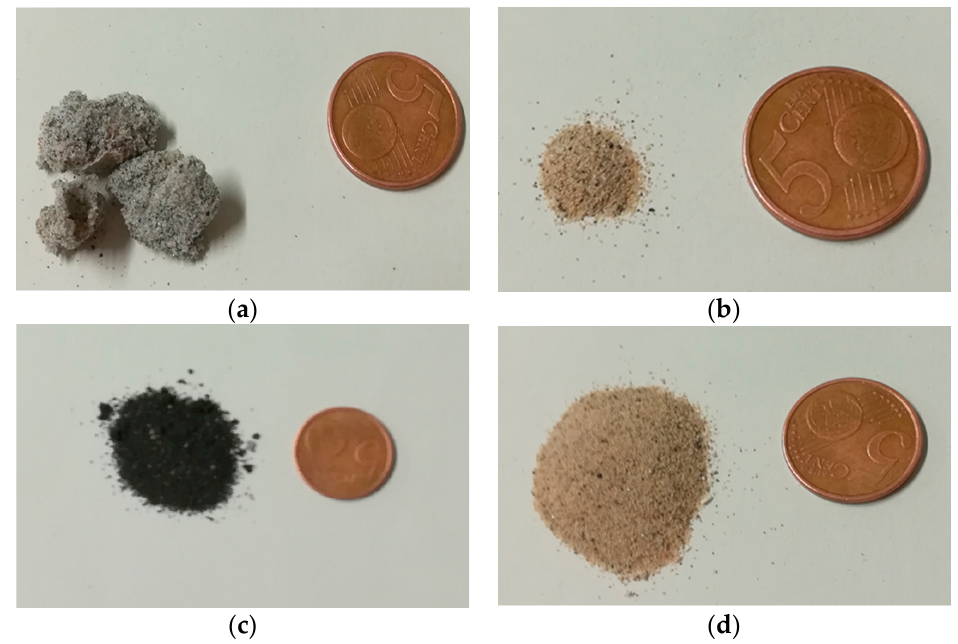
Figure 3. Examples of samples from the spent bed after the devolatilization tests: ( a ) coarse agglomerates of the bed, ( b ) top of the bed, ( c ) bottom of the bed, ( d ) intermediate part of the bed .